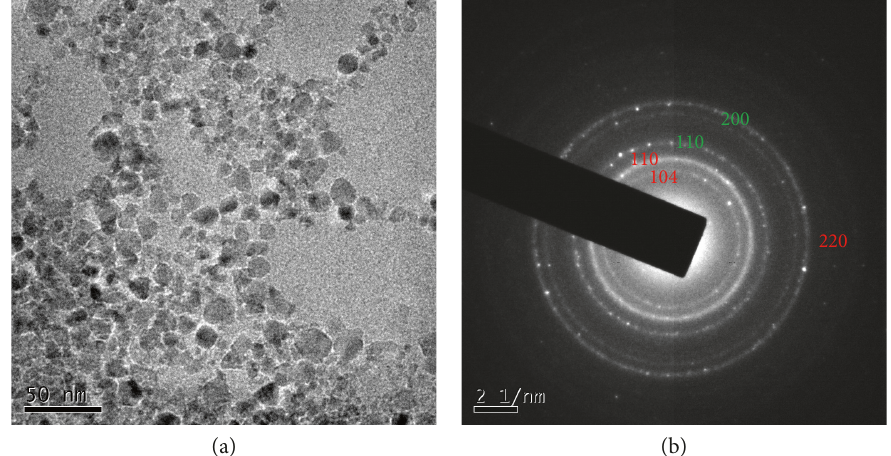
Figure 2: (a) TEM image of the ZVI nanoparticles. (b) Di ff raction pattern of ZVI nanoparticles, the green Miller indexes are for metallic iron and the red indexes are for iron